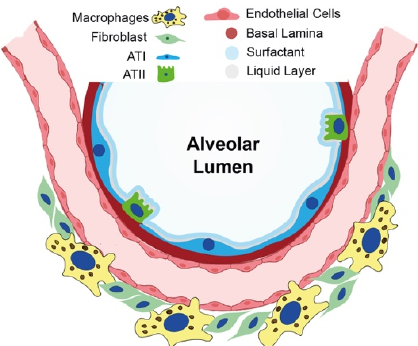
Figure 1. Cell composition of the healthy alveolus. Schematical image of the alveolar compartment: the alveolar lumen (white) is surrounded by ATI cells (blue) and ATII cells (green), which secrete surfactant (light blue). The alveolar epithelial basal lamina (pink) separates alveolar epithelial cells from alveolar endothelial cells. Pulmonary interstitial tissue is schematically represented as a compartment mainly composed of fibroblasts (light green) and macrophages (yellow), which are known to be the most relevant interstitial cell types in the pathogenesis of IPF.